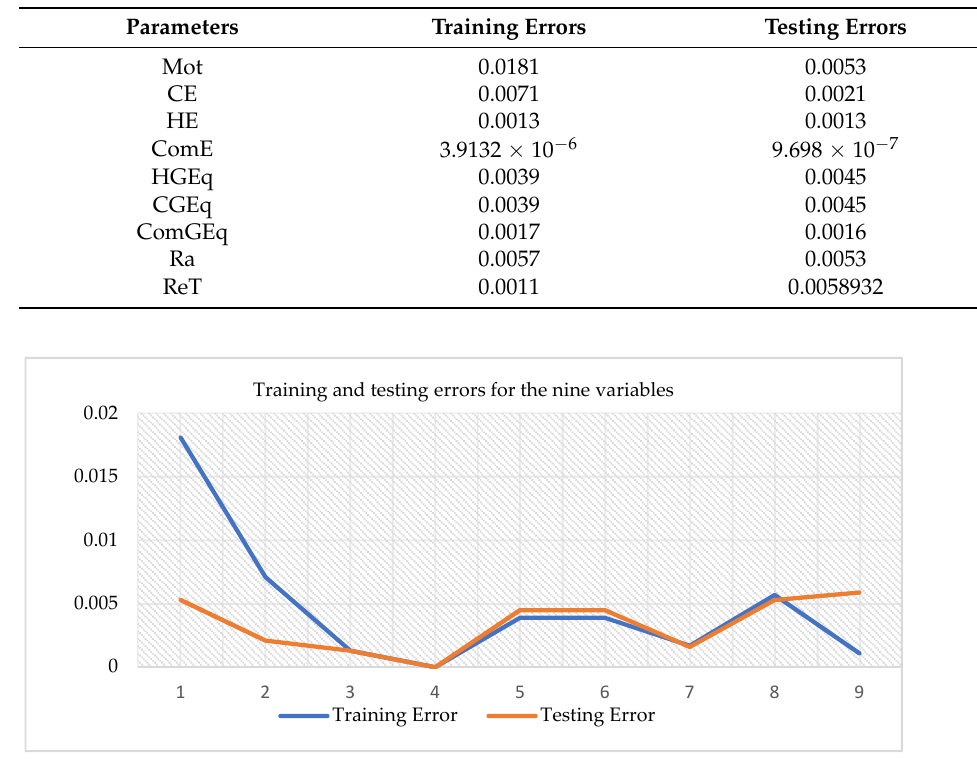
Figure 17. Training and testing errors for the nine variables.